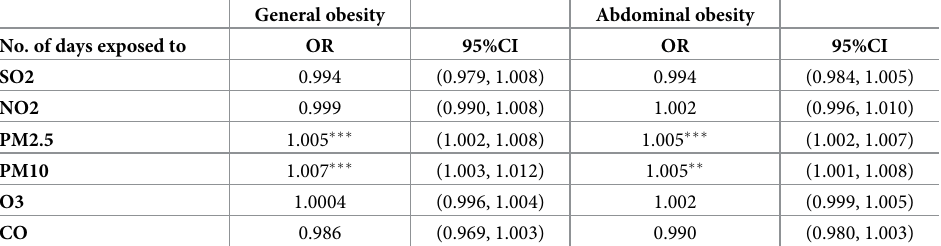
Table 5. Regression results (Odds ratio and 95%CI) for associations between six pollutants and obesity among older people from the China Health and Retirement Longitudinal Study2015.